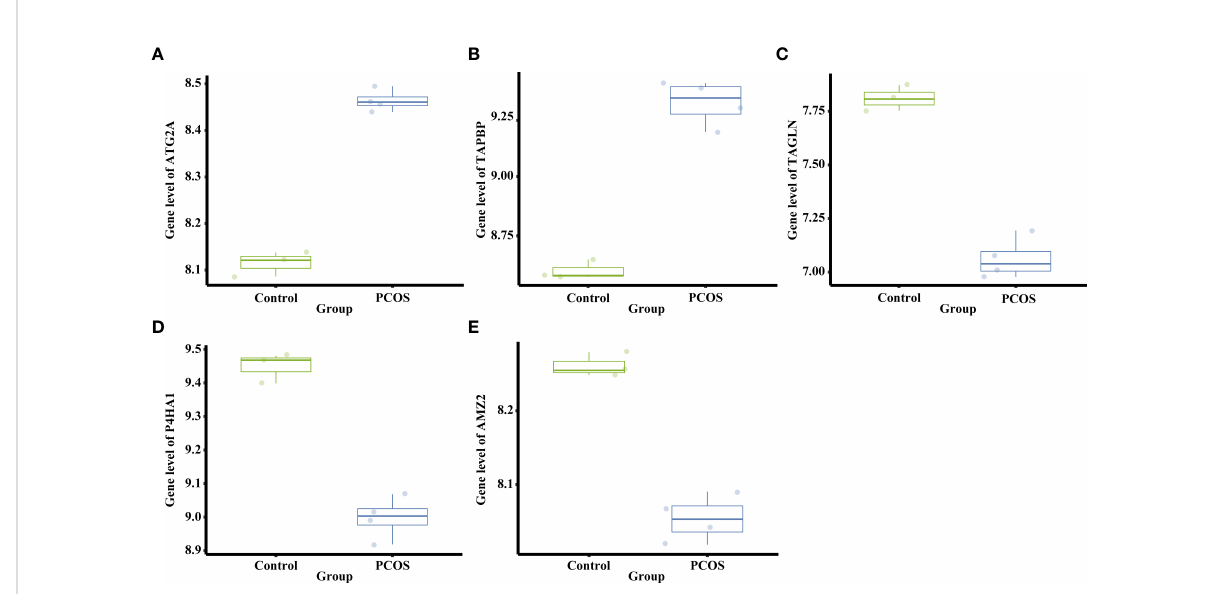
FIGURE 4 Differential mRNA expression of the top fi ve DEGs shared between PNA mice and PCOS patients. (A) The gene level of Atg2a . (B) The gene level of Tapbp . (C) The gene level of Tagln . (D) The gene level of P4ha1 . (E) The gene level of Amz2 .